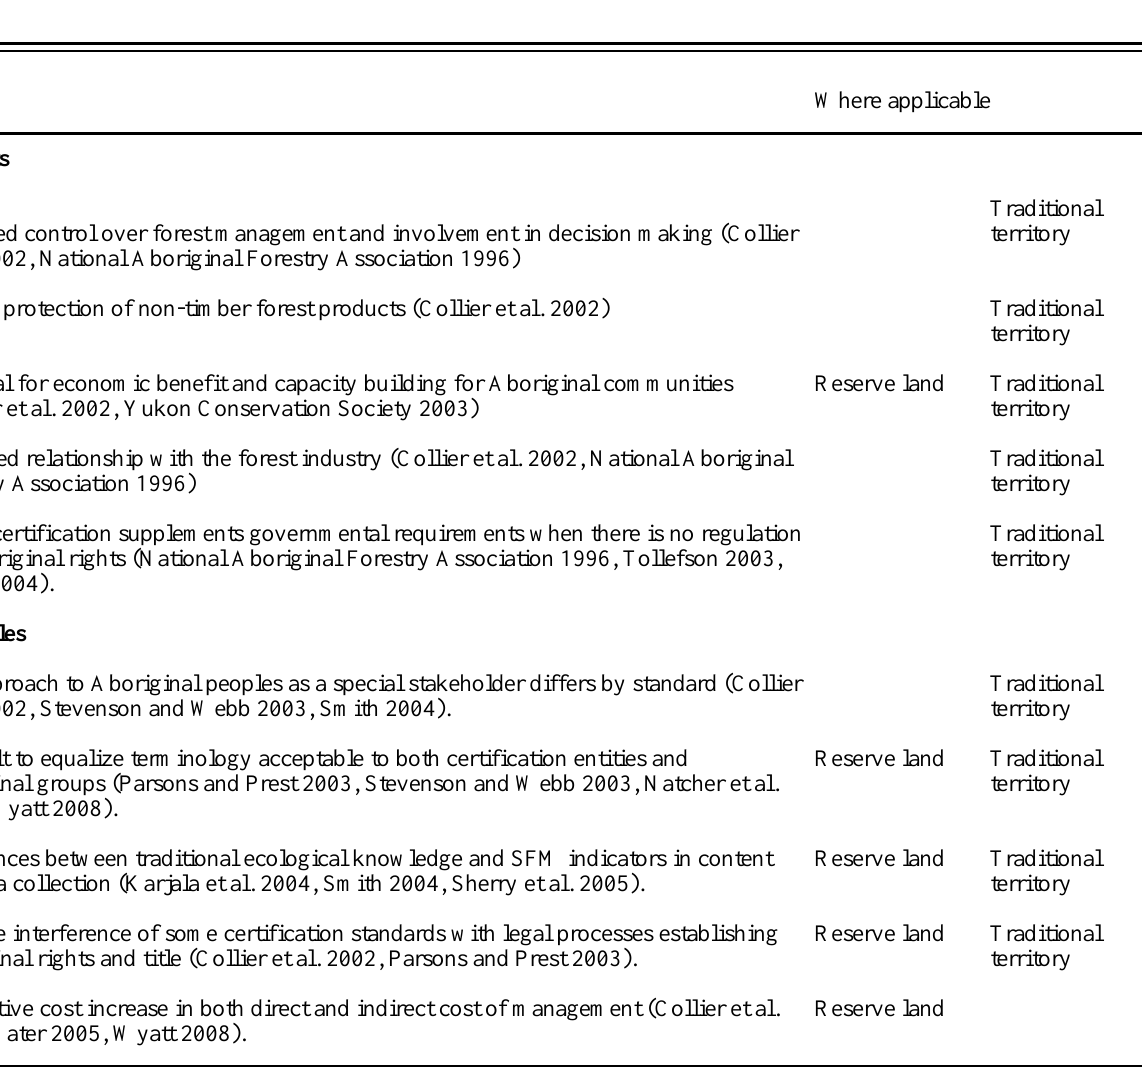
Table 2 . Potential benefits from, and obstacles to, Aboriginal commitment to forest